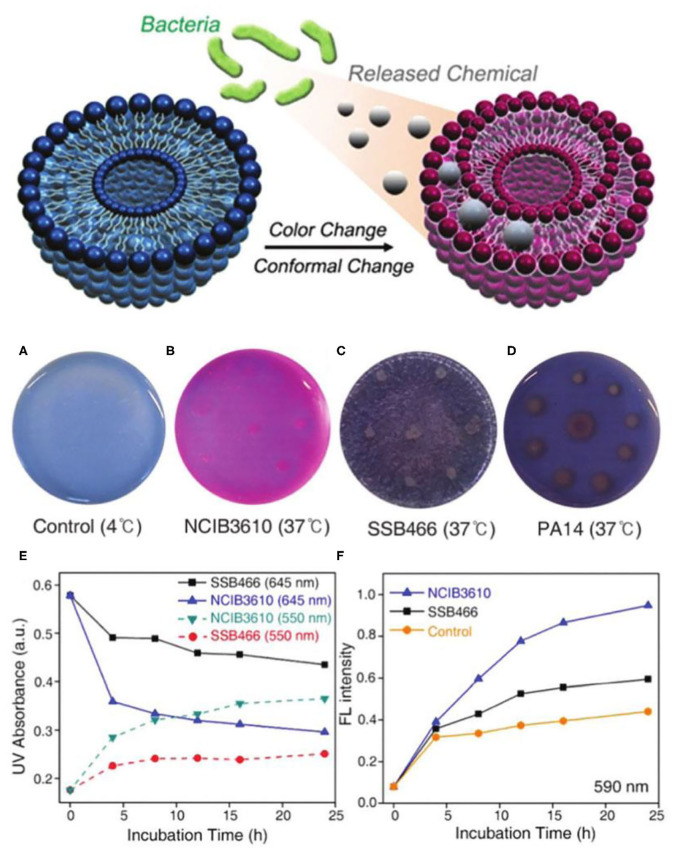
Bacteria-sensing mechanism of PDA based on the released chemical from bacteria. (A–D) Photometric change in PDA-LB-agar plate after incubation of various bacterial strains for 16 h. (E) UV/Vis and (F) fluorescence spectrum change of NCIB3610 and SSB466 incorporated PDA-LB-agarplate as function of incubation time with bacteria. Reprinted with permission from Park et al. (2016c). Copyright 2016, Royal Society of Chemistry.